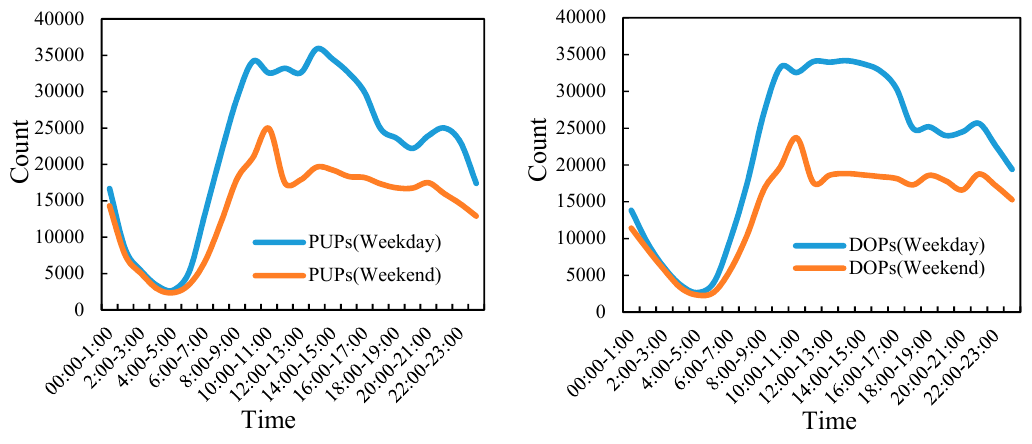
Figure 7. Temporal variance of the PUPs and DOPs activities.